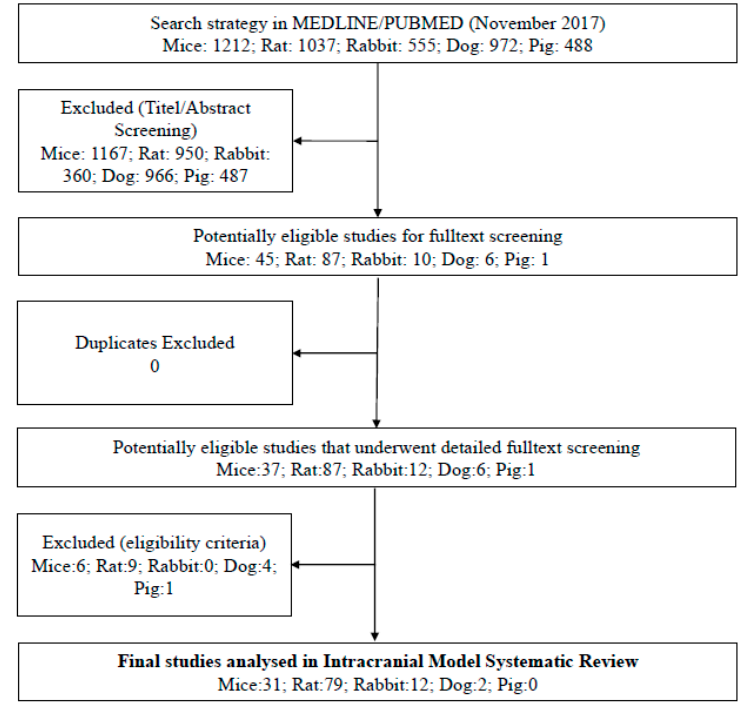
Figure 1. Preferred Reporting Items for Systematic Reviews and Meta-Analyses (PRISMA) flow chart for study selection.